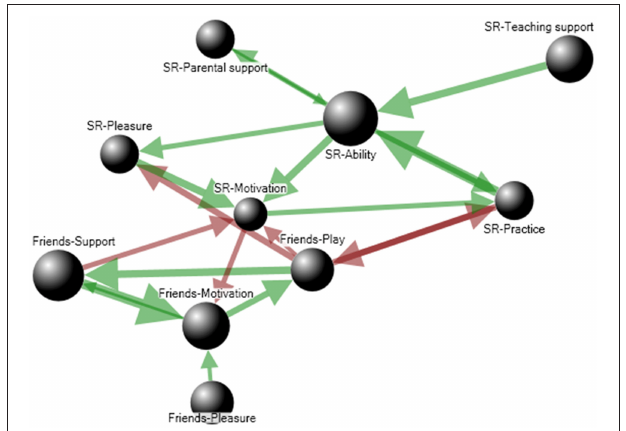
FIGURE 4 | Graphical representation of an ability network. Green arrows represent uni- or bidirectional positive influences from one node on another, red arrows represent negative